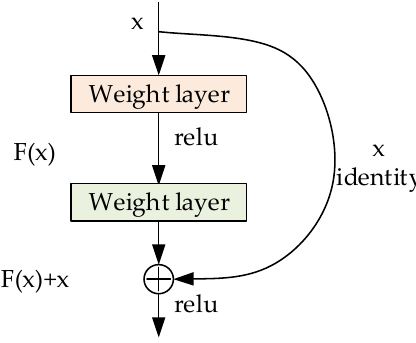
Figure 4. Residual network unit diagram.